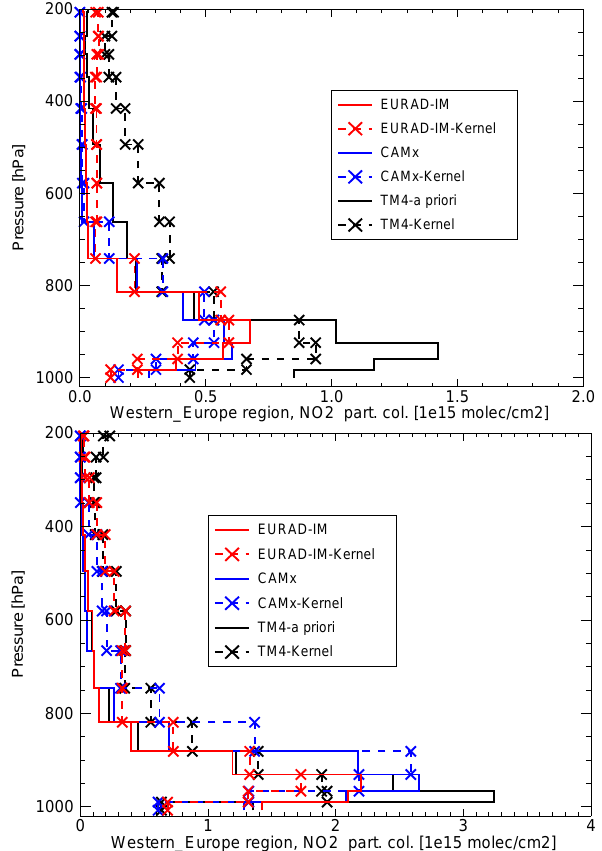
Fig. 12. Monthly mean, area-averaged partial NO 2 columns, inter- polated on TM4-vertical model grid, for CAMx and EURAD-IM, as well as the partial column multiplied with the averaging kernel. Also shown the TM4 data. Results for western Europe region, Au- gust 2008 (upper panel) and December 2008 (lower panel).